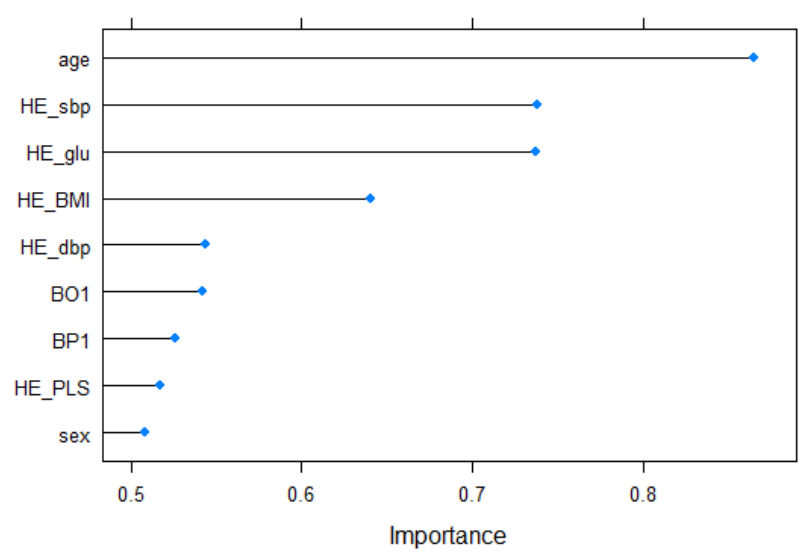
Figure 3. Features’ importance.